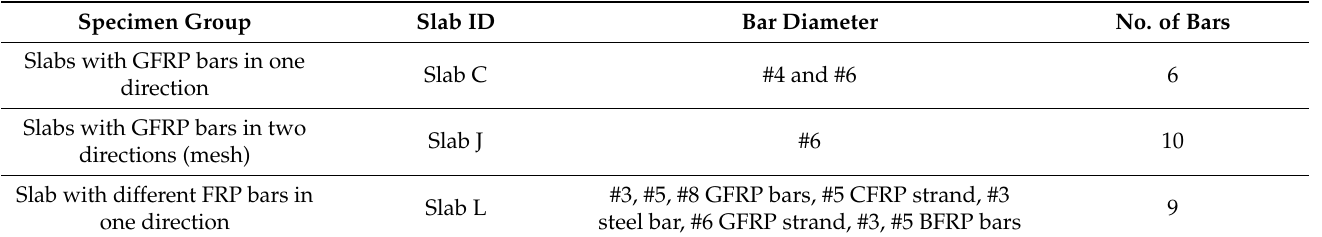
Table 1. Identification of small-scale concrete slab specimens.